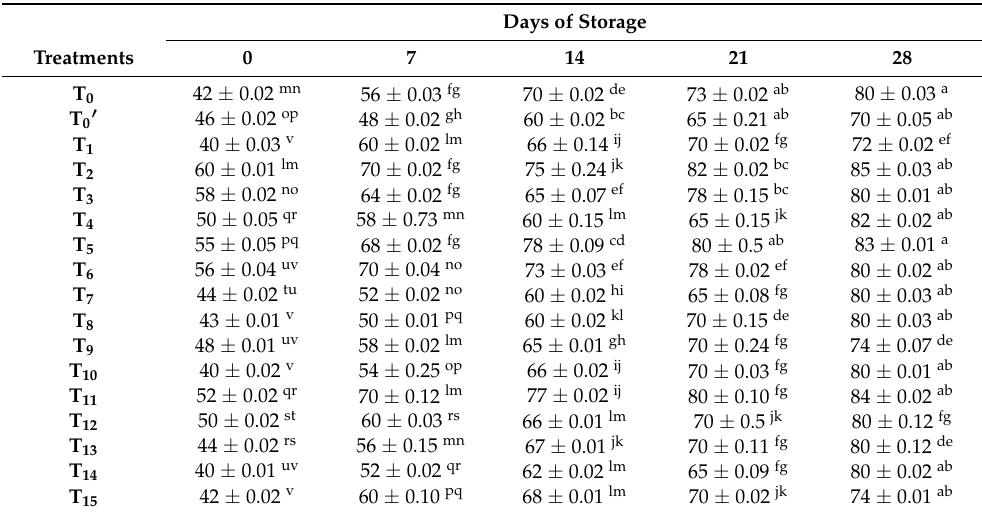
Table 6. Effect of guar gum and storage time on syneresis (%) of probiotic yoghurt prepared from hydrolyzed and non-hydrolyzed guar